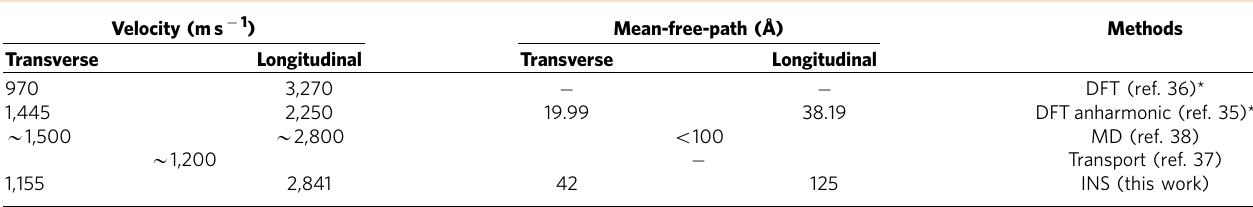
*Based on the cubic phase. The specific data of ref. 35 was requested from the